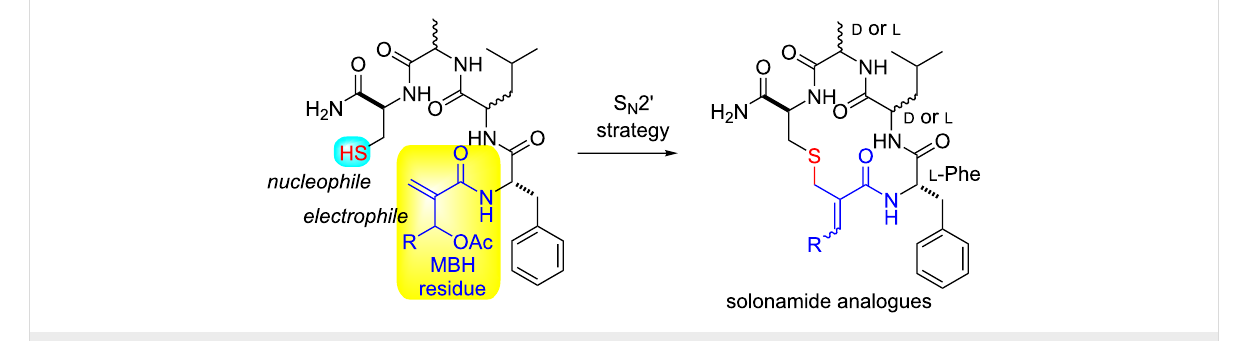
Scheme 1: Macrocyclization strategy based on S N